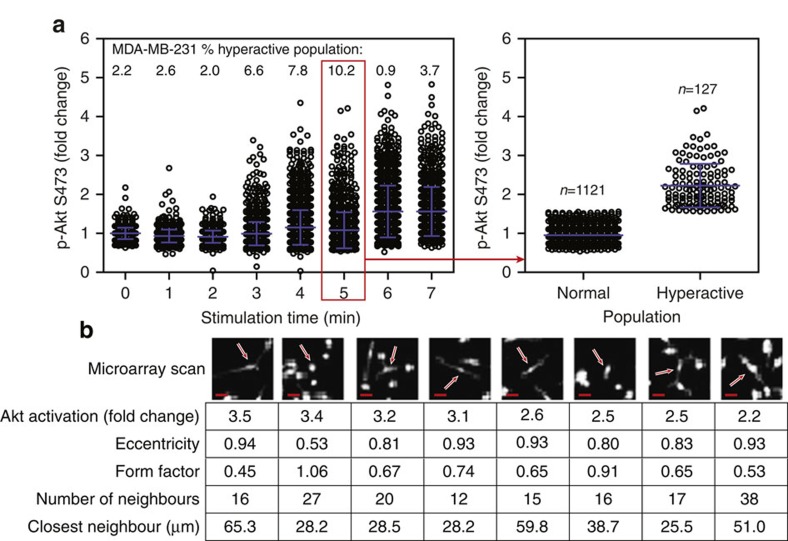
Single-cell Akt S473 phosphorylation in MDA-MB-231 cells.(a) Left: single-cell scatter plots of Akt activation after 0–7 min stimulation by 50 ng ml−1 of PDGF-BB. Data are shown as population mean±1 s.d. (representing a total of 946–2,219 cells per condition), with the percentage of hyperactive responders indicated above each time point. The most hyperactive responders (red box) were observed at 5 min stimulation. Right: differential single-cell scatter plots of Akt activation for the hyperactive and normal populations (population mean±1 s.d. representing 1,121 normal cells and 127 hyperactive cells) 5 min after stimulation. (b) Microarray scans of eight representative hyperactive cells observed 5 min after stimulation (red arrows indicate each cell) and table summarizing each cell's Akt phosphorylation level, shape parameters and neighbour analysis. Scale bars, 25 μm.